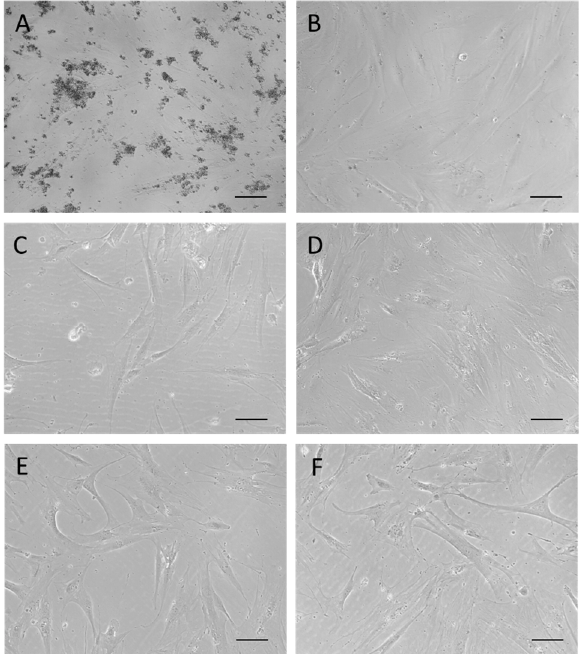
Figure 7. Micrographs at the inverted optical microscope of hMSCs in culture after 24 h of treatment with: ( A ) CN at 10 µg/mL; ( B ) NL at 10 µg/mL; ( C ) CN-NL at 0.2 µg/mL; ( D ) CN-NL/GA at 0.5 µg/mL; ( E ) GA at 0.5 µg/mL; ( F ) control. Micrographs are representative of each compound administrated at the intermediate concentration in the tested ranges. Original magnification 100×, scale bar = 100 µm.